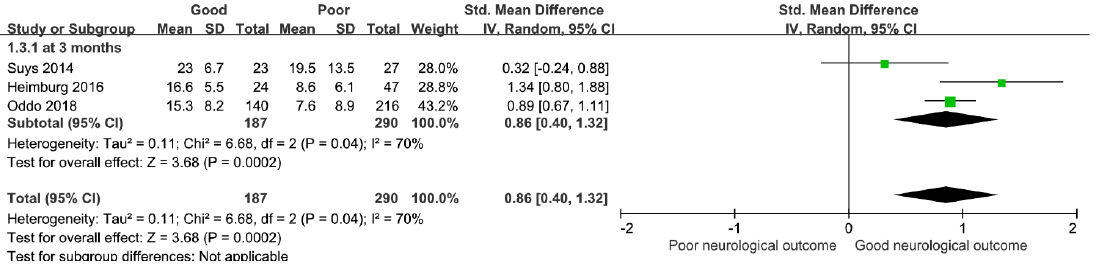
Figure 3. Forest plot for percent constriction of pupillary light reflex measured at 24–48 h after hospital admission and neurological outcome at 3 months. CI, confidence interval; SD, standard deviation.